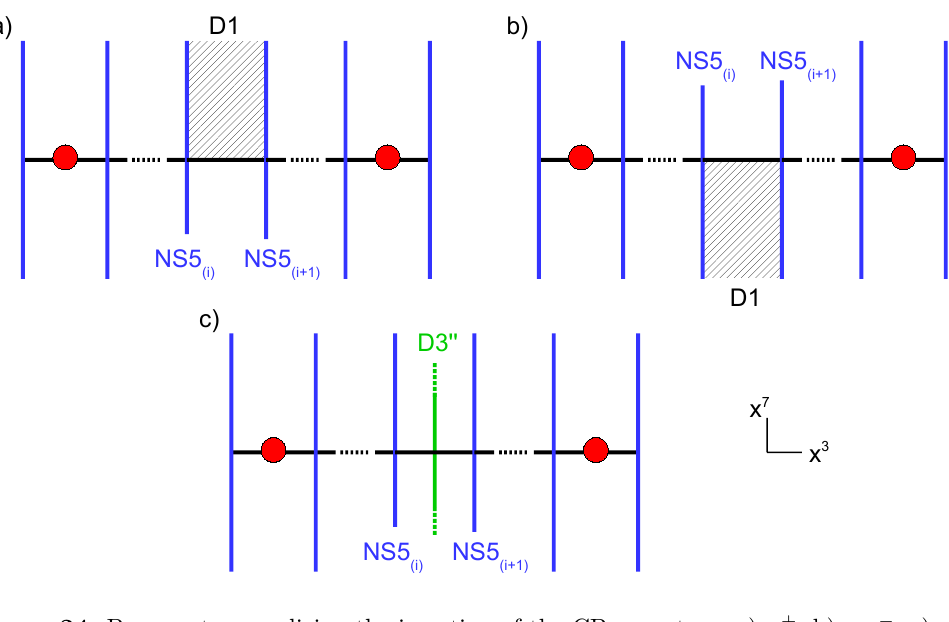
Figure 24 . Brane setups realizing the insertion of the CB operators: a) u +